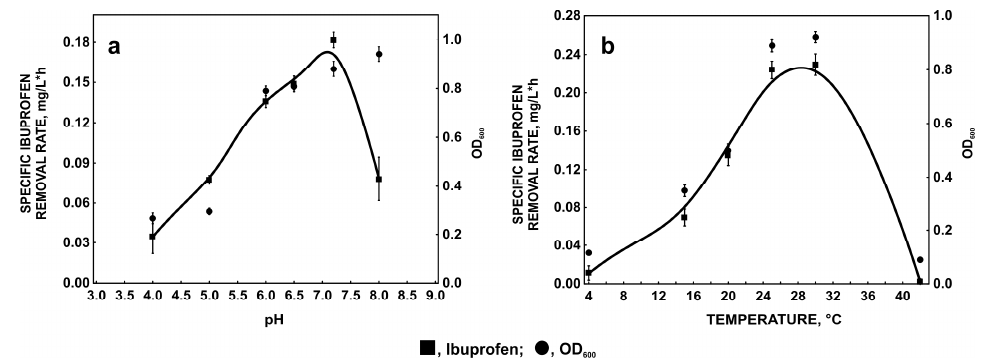
Figure 1. Influence of pH ( a ) and temperature ( b ) on the specific ibuprofen removal rate and bacterial growth expressed as an optical density at 600 nm. The data points represent the average of three independent experiments.